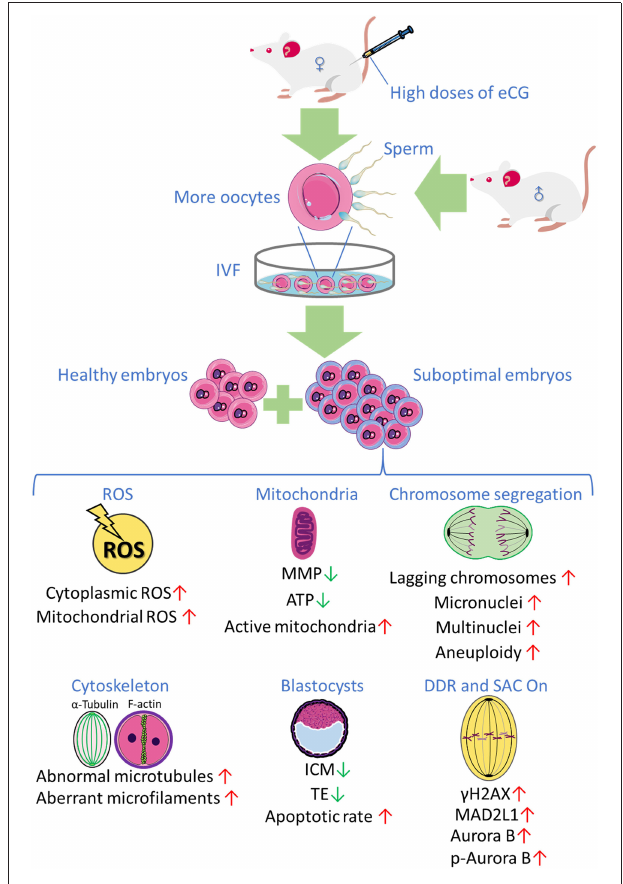
FIGURE 7 | The research findings obtained in the present study reveal that priming with high doses of eCG exerts marked adverse effects on certain developmental competences of IVF-derived mouse